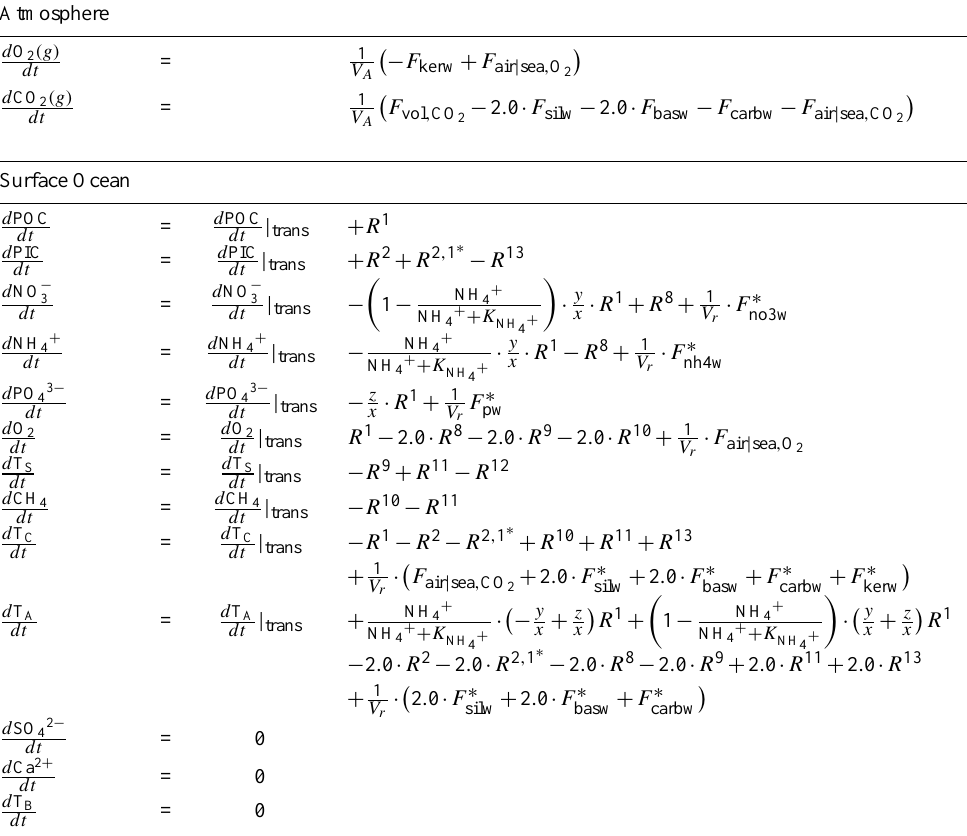
Table 1. Differential equations for the evolution of concentrations in the different reservoirs of the Earth system. The transport term dC i summarizes the transport processes as described in Sects. 2.3.1 and 2.4. The biogeochemical reaction network is described in Sects. 2.3.2 and 2.4 and synthesised in Table 5. Exchange fluxes are detailed in Sects. 2.2.1 and 2.3.3. V r denotes the volume of the respective reservoirs (r=ES, ED, IS, ID, PS, PD). x , y and z indicate the carbon, nitrogen and phosphorus contents of organic matter, respectively. ∗ Note that shallow carbonate precipitation R 2 , 1 and weathering fluxes, F weathering , only affect the epicontinental surface ocean ES and equal zero in the differential equations for the polar and inner ocean surface layers. + Hydrothermal fluxes, F mor , only affect the evolution in the deep inner ocean ID and equal zero in the differential equations for the deep polar and epicontinental oceans. The oceanic reservoirs of sulfate, calcium and boron are imposed and concentrations are constrained based on available observations, or simulated